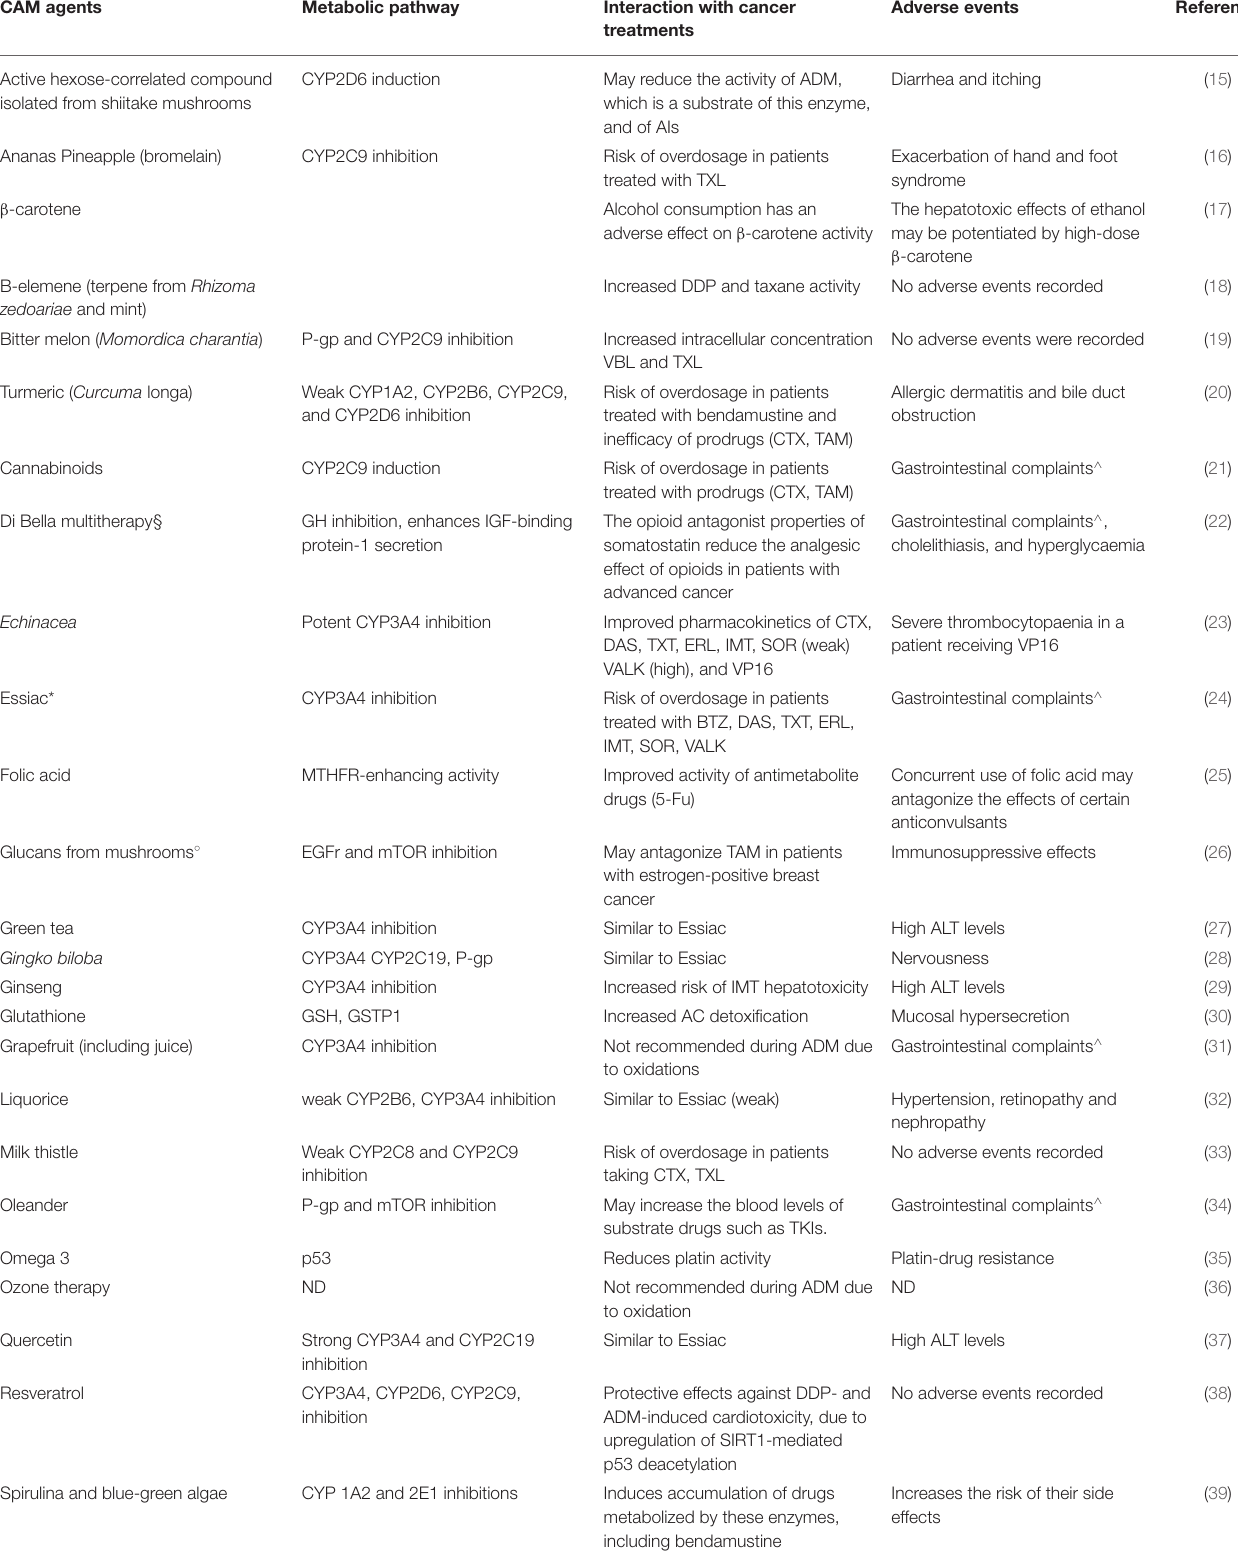
TABLE 1 | Most common CAM interventions adopted by cancer patients and possible interactions with AC. CAM